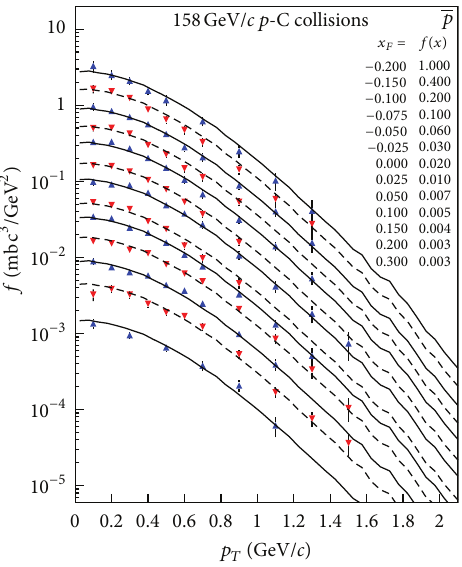
Figure1:Transversemomentumdistributionsofantiprotonsin 𝑝 -C collisions at 158 GeV/ c . The symbols represent the experimental data oftheNA49Collaboration[18]atdifferent 𝑥 𝐹 ,andthecurvesareour results calculated by the multisource thermal model.